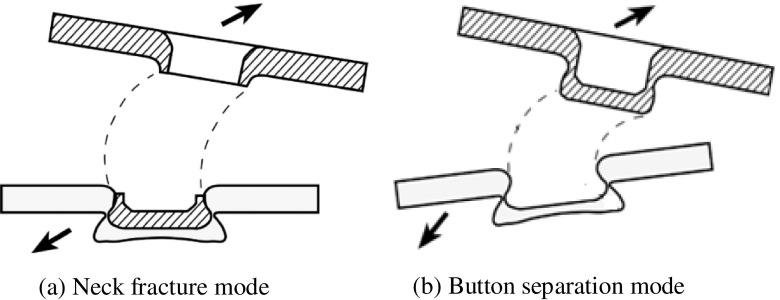
Failure modes of clinched joints [63].